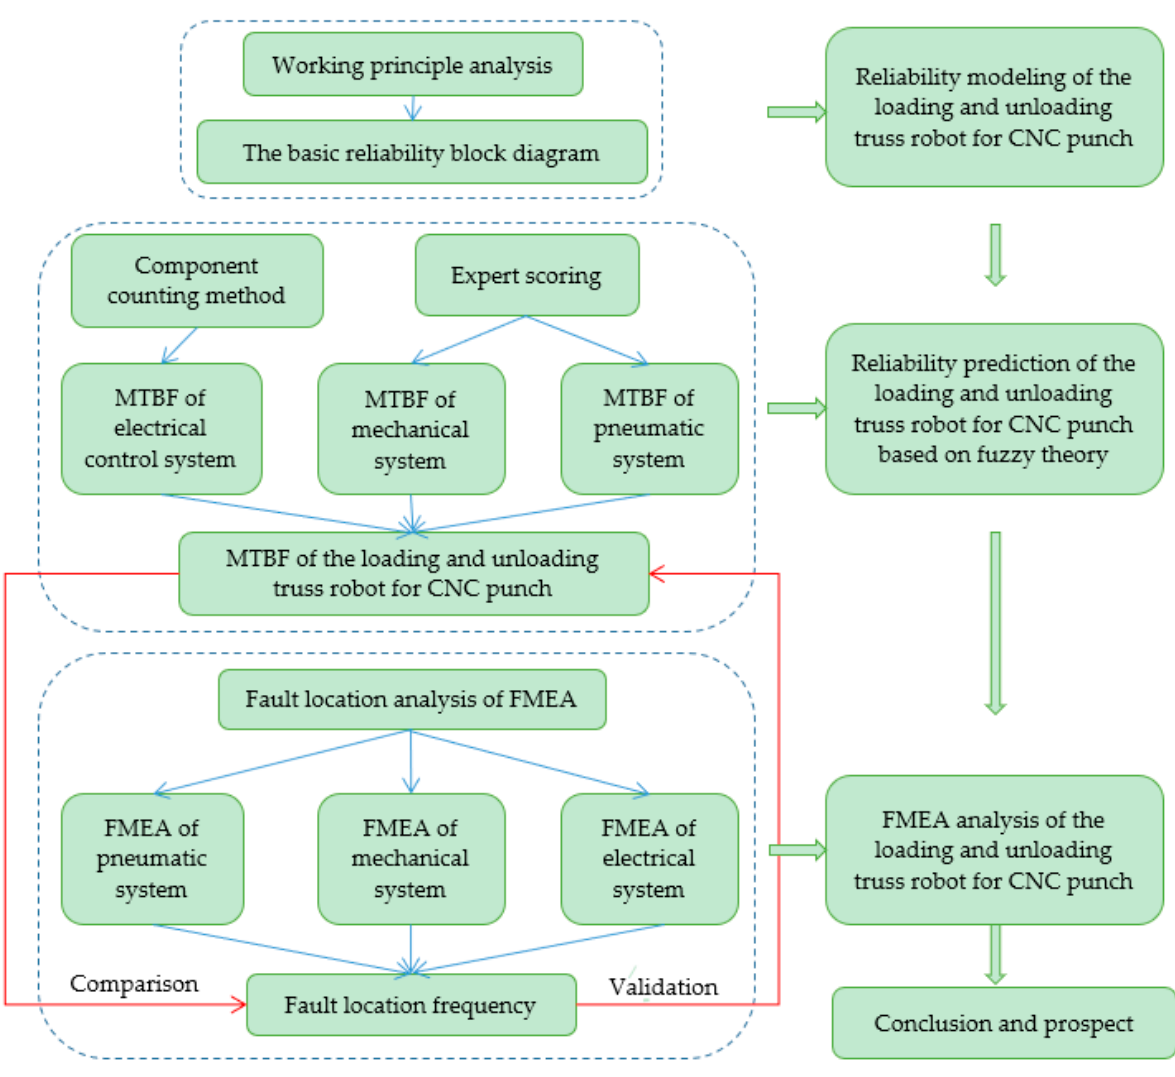
Figure 1. Flow diagram of reliability prediction and FMEA analysis of the loading and unloading truss robot for CNC punch.